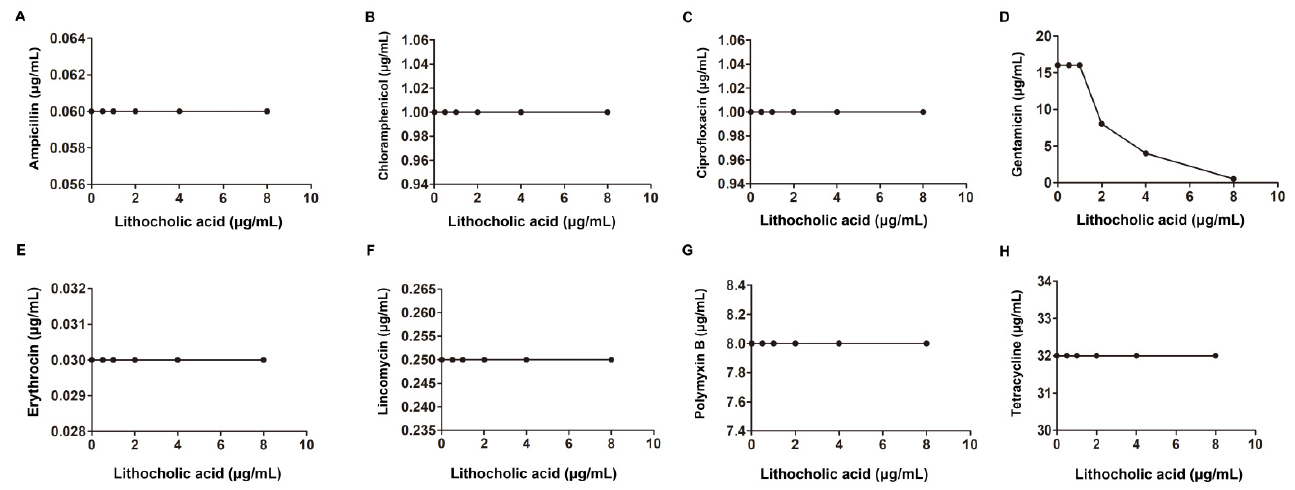
Figure 4. Interaction of LCA with Amp, Ery, Genta, Cip, Lin, Tet, Cpl and Pmb against S. suis ( A – H ).